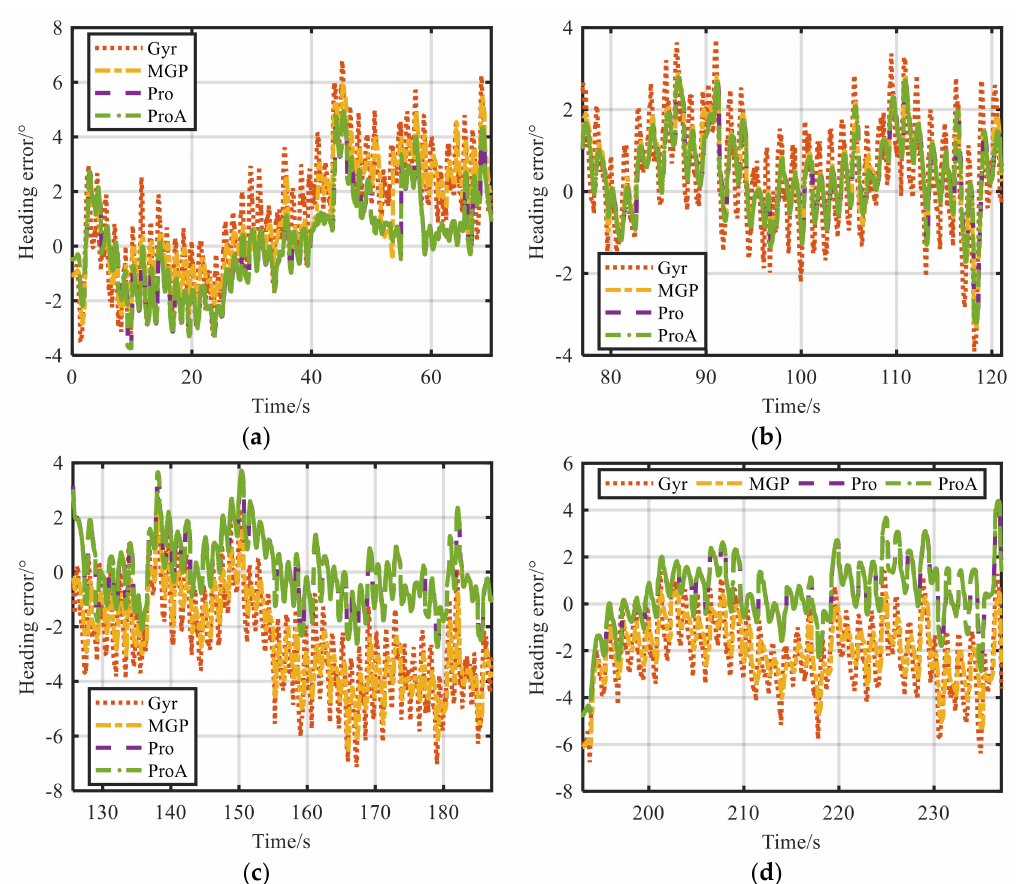
Figure 5. Heading error of local trajectory for HV9: ( a ) Heading error of mark A; ( b ) Heading error of mark B; ( c ) Heading error of mark C; ( d ) Heading error of mark